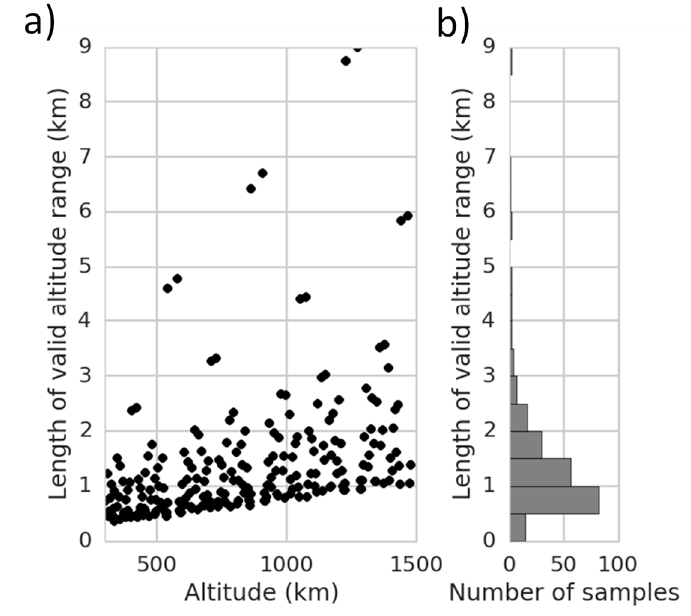
Figure 11. Length of the valid altitude bands (green regions from Figure 10b) for all altitudes and the inclination of the ERS orbit. Each dot in panel ( a ) is one green altitude range where the mesoscale correlation is always lower than 0.5. Panel ( b ) shows the associated distribution.